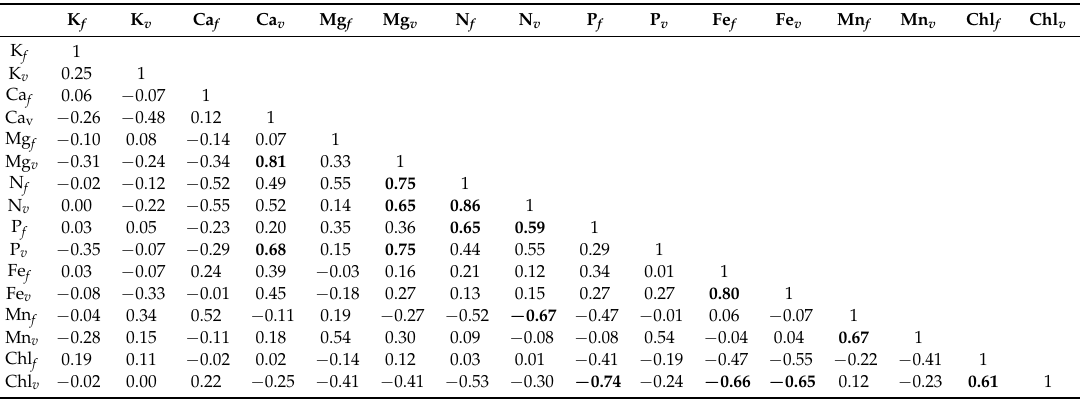
Table 5. Correlations among different nutrient contents in the petiole analyses in the two stages under study, and the chlorophyll contents (Chl) in those two stages. Subscripts f and v stand for fruit set and veraison, respectively. Statistically significant values ( p < 0.05) are highlighted in